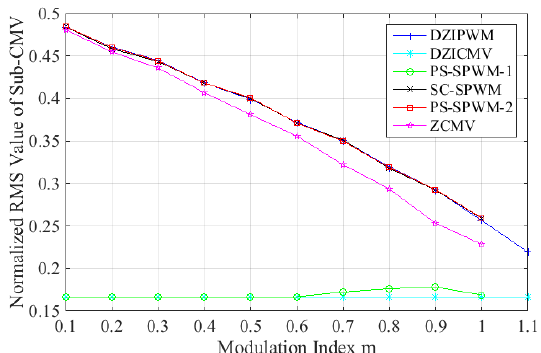
Figure 30. Normalized RMS value of sub-CMV in the experiment.